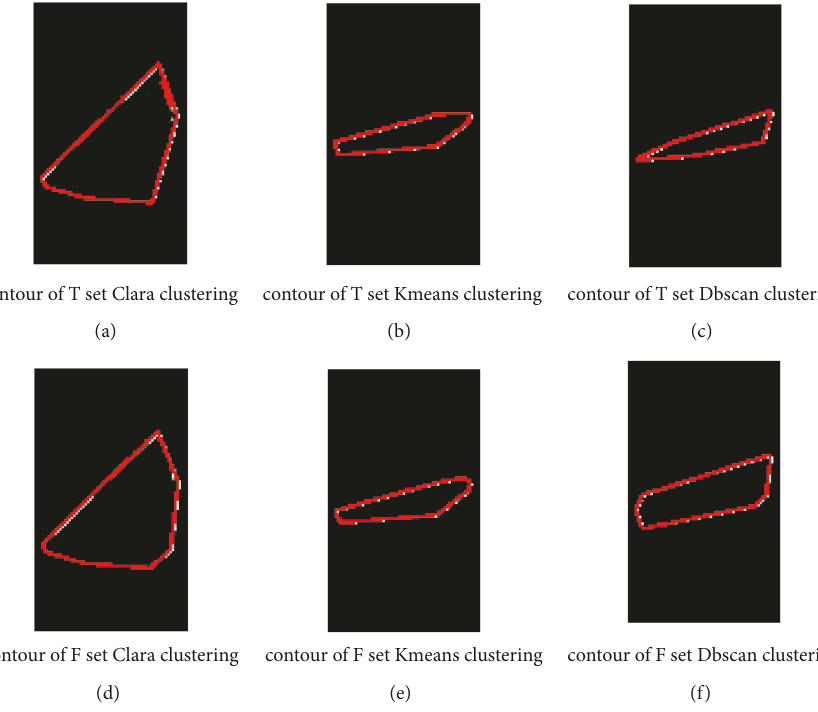
Figure 7: (a)Contourof Tsets Claraclustering.(b)Contourof T setsKmeans clustering.(c)Contourof T sets Dbscanclustering.(d) Contour of F sets Clara clustering. (e) Contour of F sets Kmeans clustering. (f) Contour of F sets Dbscan clustering.